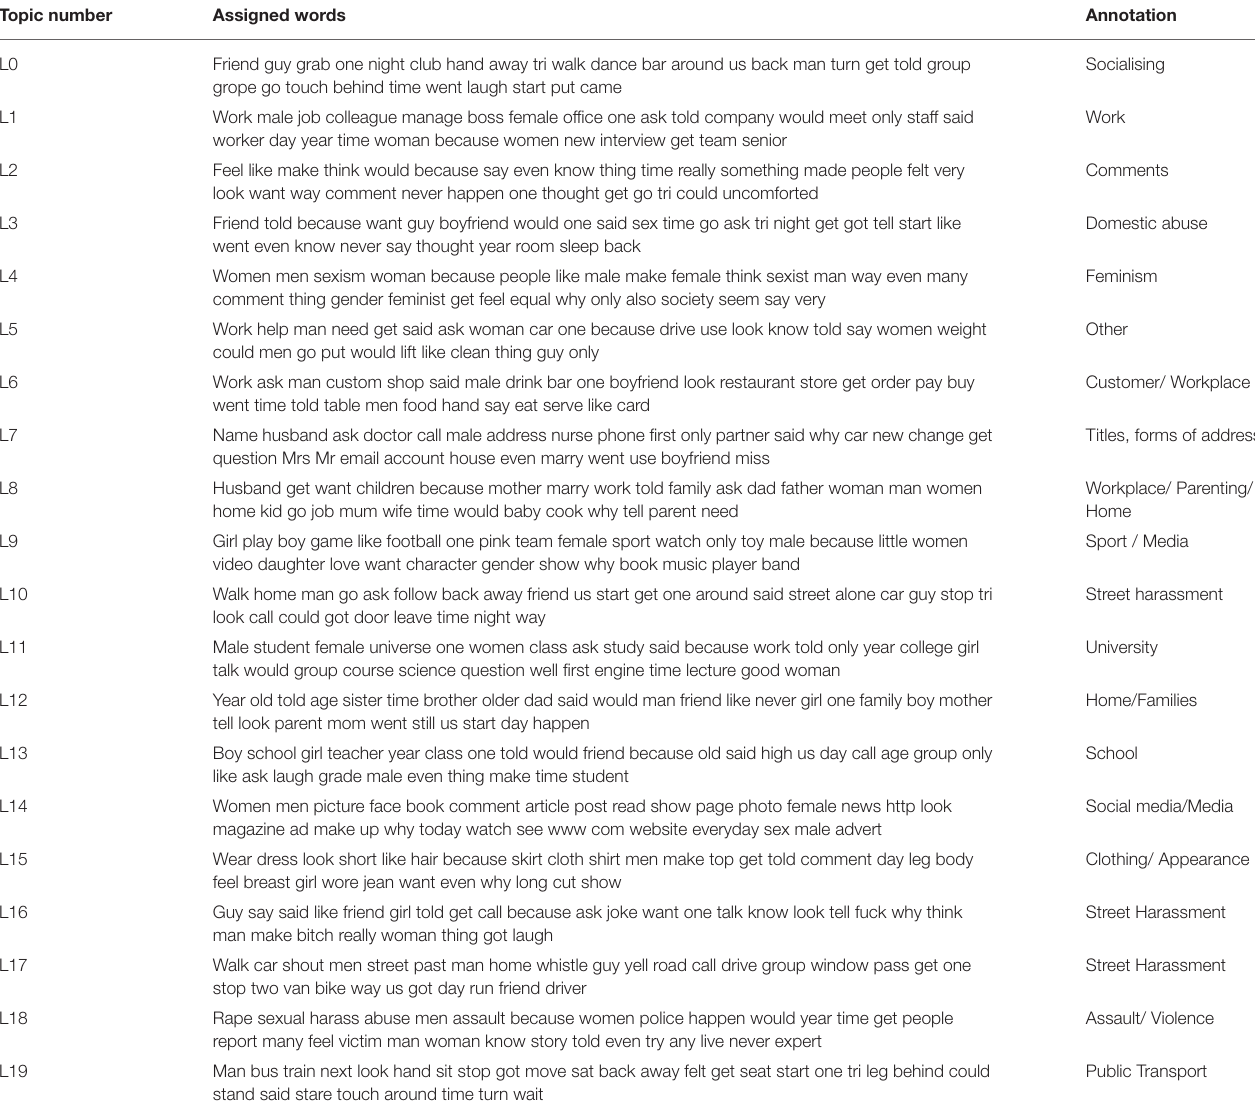
TABLE 2 | Topics computationally extracted from the Everyday Sexism website content and annotated qualitatively for n = 20. Topic number